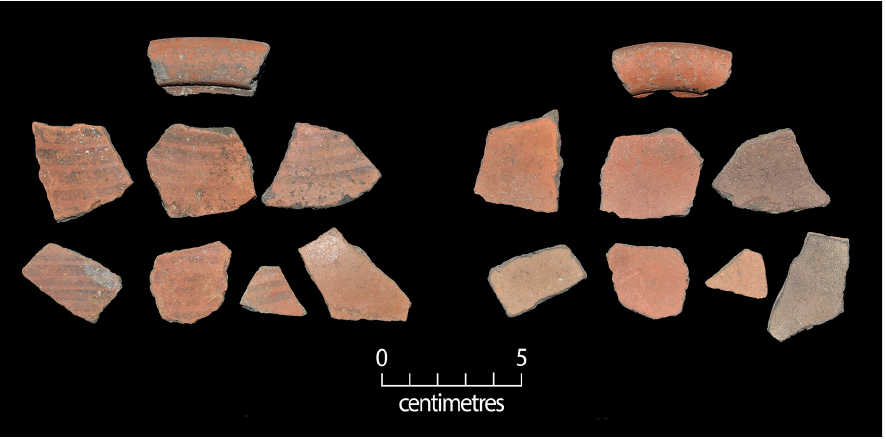
Figure 8: External and internal surfaces of various Class 2 variant 6 potsherds, including one rim and five body